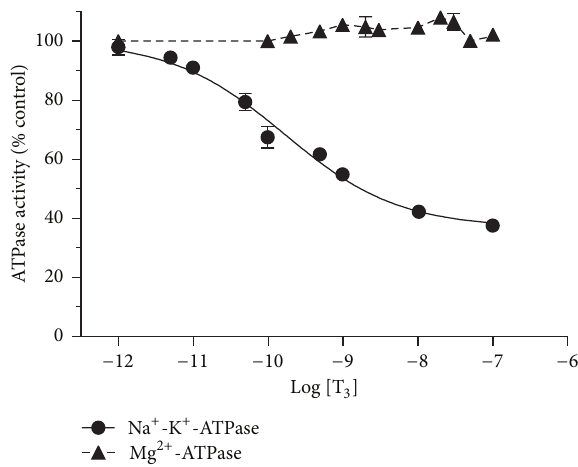
Figure1:Inhibitoryeffectofvariousdoses(0.001 nM–100nM)ofT 3 on synaptosomal Na + -K + -ATPase or Mg 2+ -ATPase activity, in vitro . Thedataarerepresentedasmean ± SEMoftenseparateexperiments, taking six animals in each group. The vertical lines denote SEM. Filled circles indicate Na + -K + -ATPase while filled triangles indicate Mg 2+ -ATPase activity.